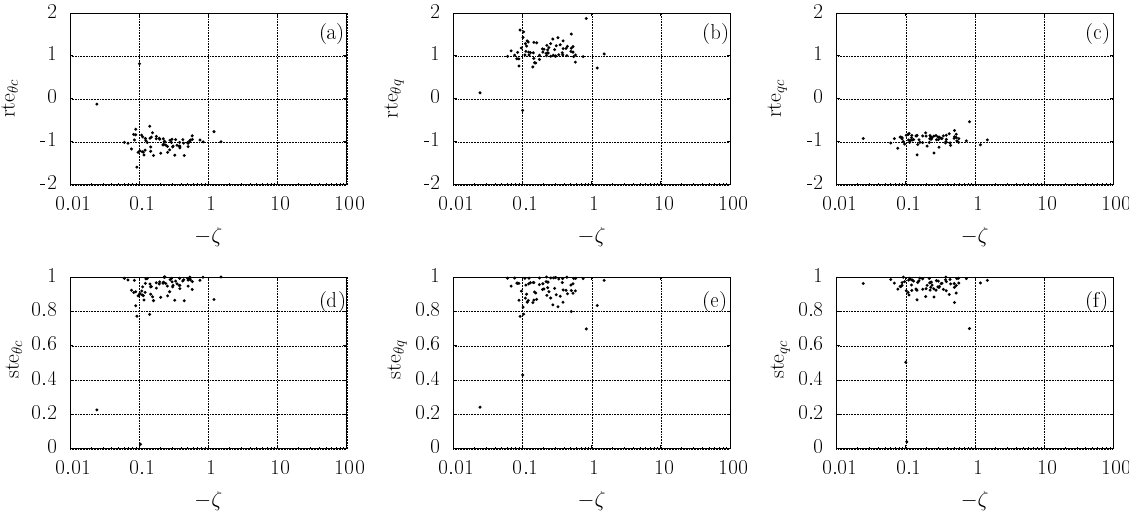
Figure 7. Scalar flux similarity indices rte (above) and ste (below) for 0 ◦ < | Z |≤ 20 ◦ : θ − c (a, d) ; θ − q (b, e) ; and q − c (c, f) . For rte, some data points were off the scale.